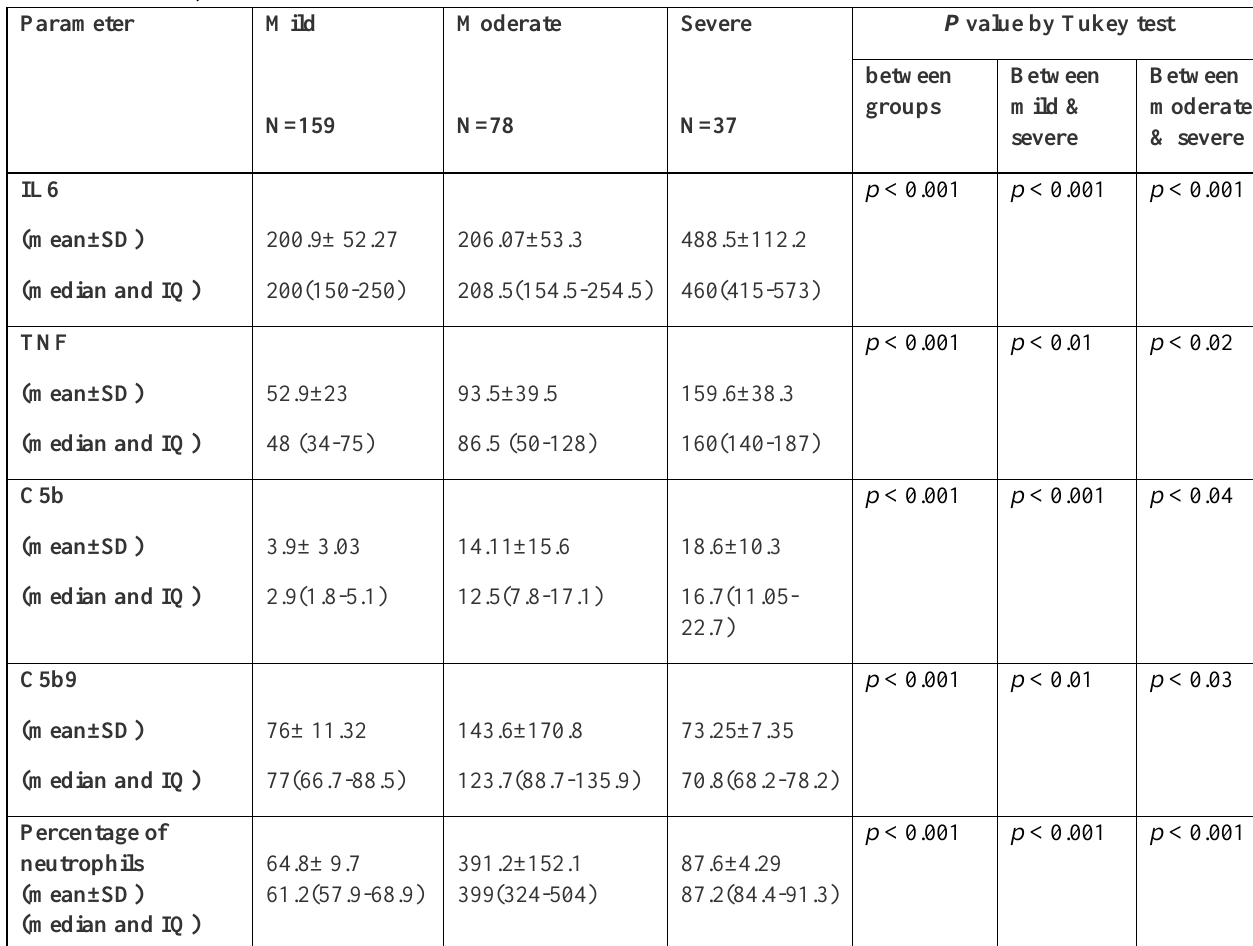
Table 2. Mean difference of IL6, TNF-α, C5b, C5b-9 and percentages of neutrophils in mild, moderate, and severe COVID-19